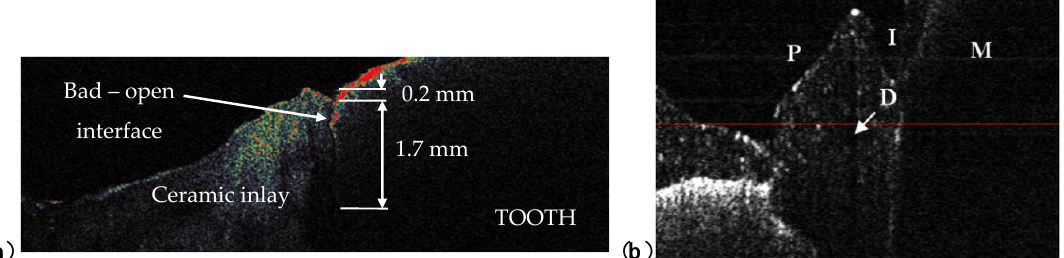
Figure 18. ( a ) OCT B-scan of a treated dental cavity obtained with an in-house developed 1D GS-based OCT handheld probe [30,48], which allows for the evaluation of the interface between a tooth and the ceramic inlay: apparently good interface, closed, but with a crack between tooth and inlay; ( b ) OCT B-scan of a metal ceramic dental prosthesis using the same 1D GS-based handheld probe and an SD-OCT system [48], with the following notations: M, 1st molar (M); P, 1st premolar; D, defect in the ceramic layer; I, interface between M and P.